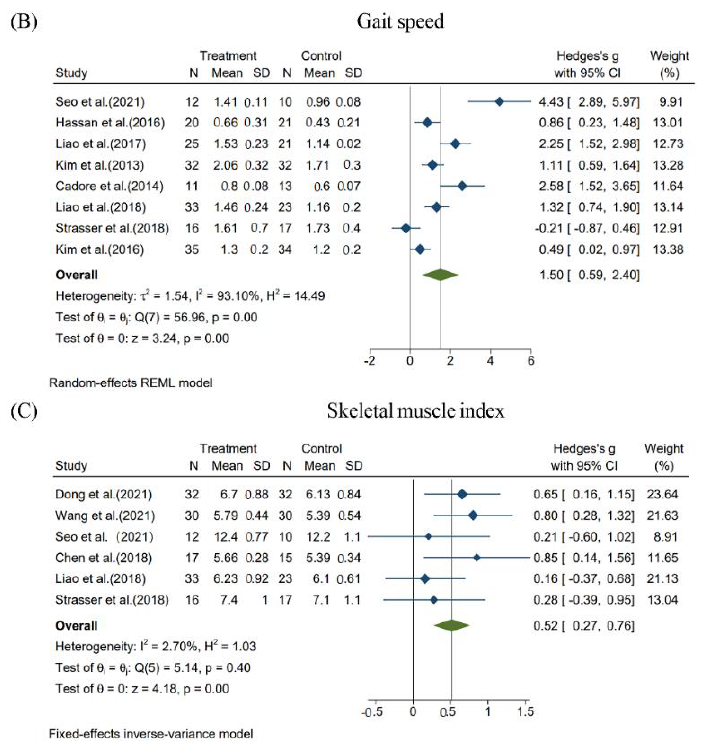
Figure 2. Effects of resistance training on grip strength, gait speed and skeletal muscle index in elderly patients with sarcopenia. ( A ) Effect of resistance training on grip strength. ( B ) Effect of resistance training on gait speed. ( C ) Effect of resistance training on skeletal muscle index [17–29].